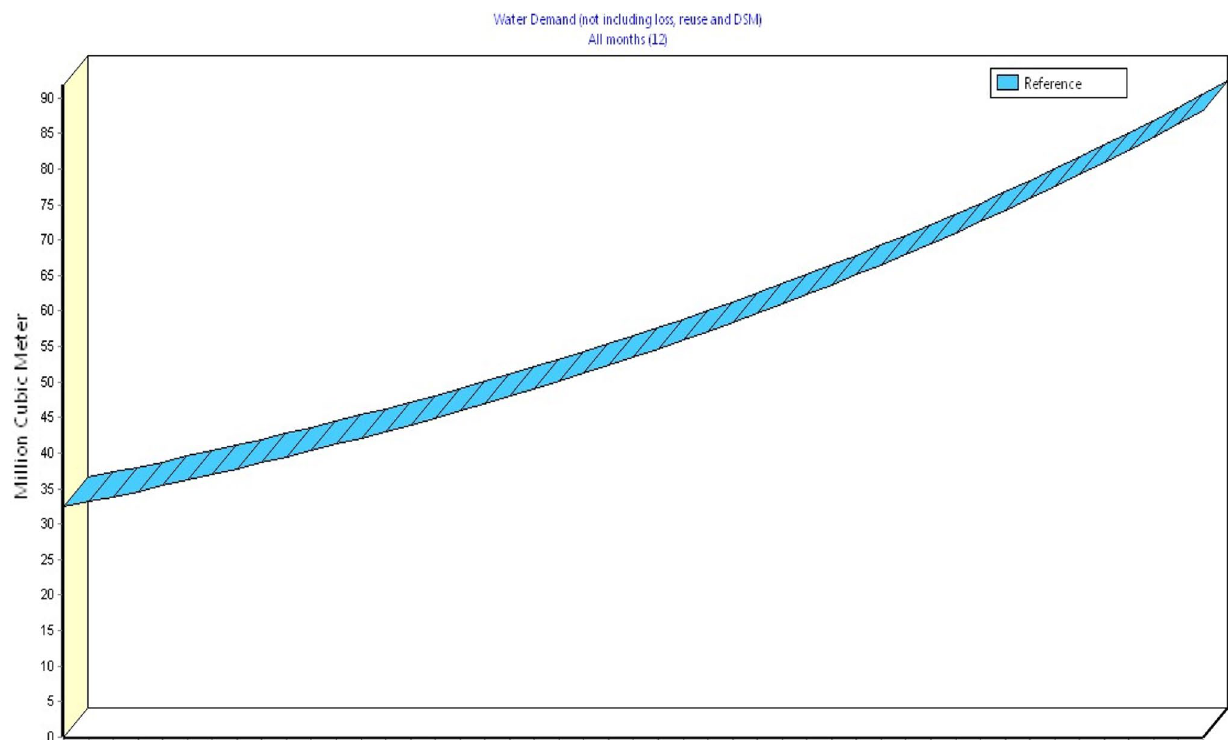
Fig. 5 Evolution of water demand in Bechar city—reference scenario; source: own